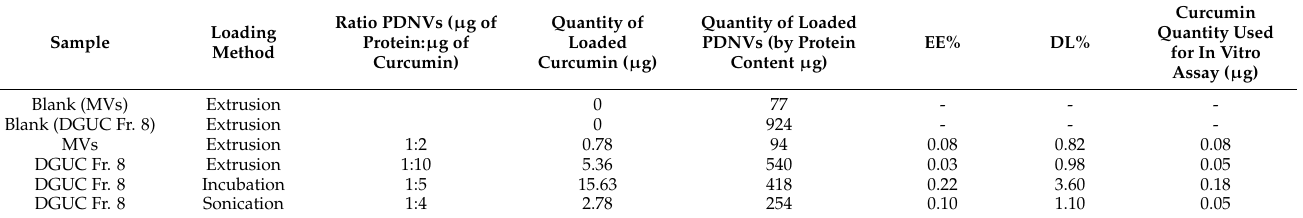
Figure 7. Schematic representation of the process to prepare curcumin loaded tomato nanovesicles by three methods: extrusion, direct loading by incubation followed by sucrose density gradient ultracentrifugation, and sonication. Table 2. Loading of curcumin into tomato vesicles using three methods: extrusion, direct loading and loading by sonication. Entrapment efficiency (EE%) and drug loading capacity (DL%) were determined.